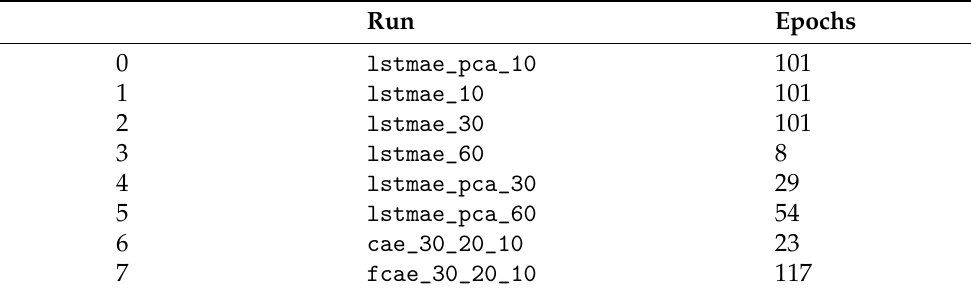
Table 6. Runs performed with the number of epochs.